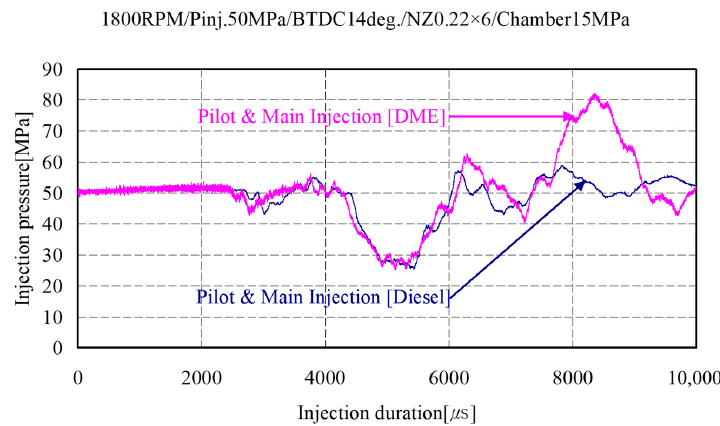
Figure 6. Injection line pressure between the rail chamber and the injector as a function of the following: with pilot injection of the injection duration for diesel and DME.